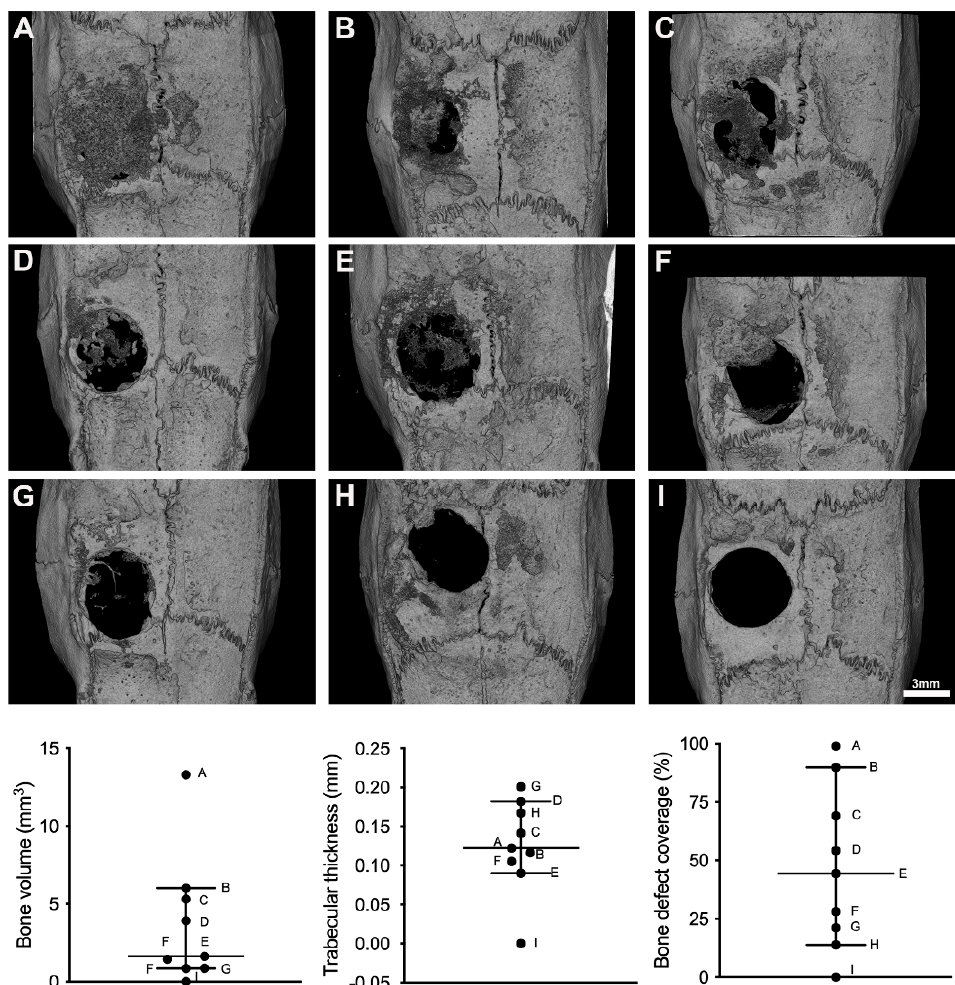
Figure 8. MicroCT analysis of defect coverage. The images show the defect viewed from above. The partial mineralization of the defect is visible. Within the regions of interest representing the defect margins, we measured the bone volume in mm 3 , the mean trabecular thickness in mm, and the defect coverage in %. Please note the large variation of the newly formed mineralized tissue within the nine specimens. The bars show the median and 95% confidence interval.